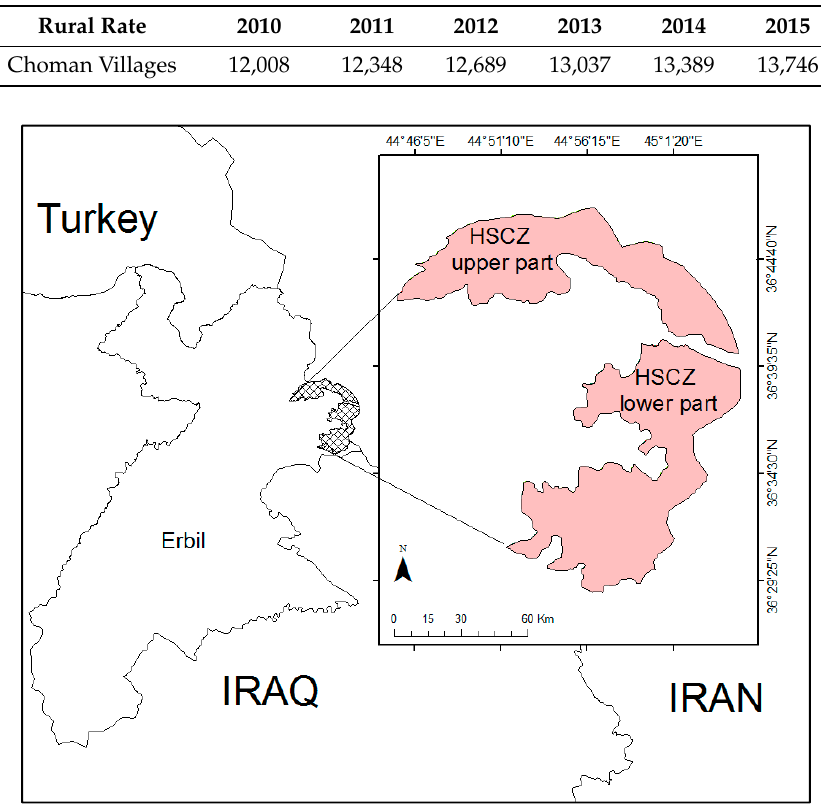
Table 1. Rural population for villages around Choman district [38].